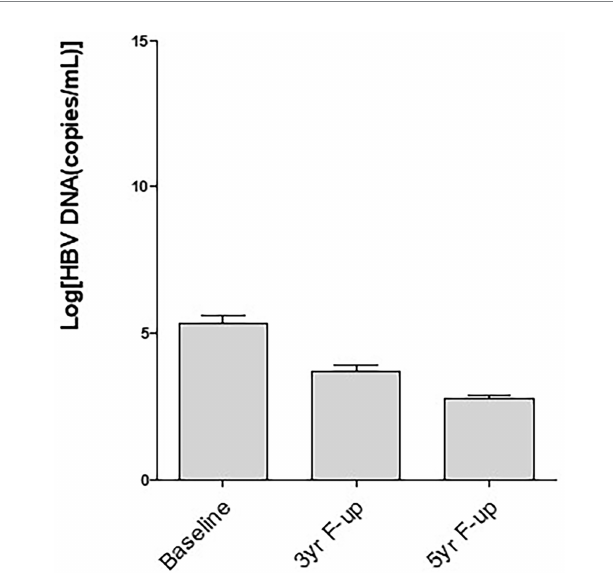
FIGURE 1 Decrease of hepatitis B virus (HBV) DNA in the sera along with time after therapy with a therapeutic vaccine (NASVAC). Baseline: The levels of HBV DNA evaluated before start of therapy; 3 yr-F-up: The level of HBV DNA 3-year after end of therapy; 5-yr-F-up: The levels of HBV DNA 5-year after end of treatment. Mean and standard deviation of HBV DNA of the evaluated patients have been shown.